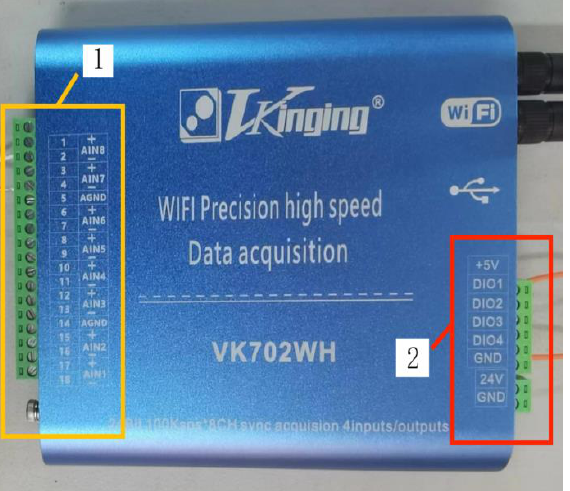
Figure 11. Data acquisition card port: (1) digital signal acquisition terminal and (2) analog signal output terminal.